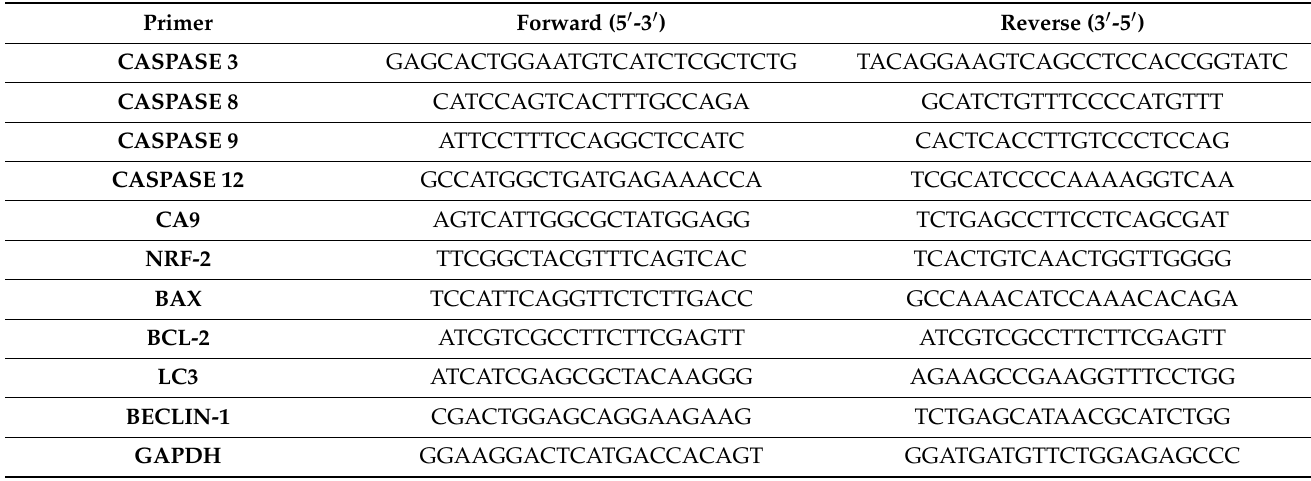
Table 2. Primer sequences used for